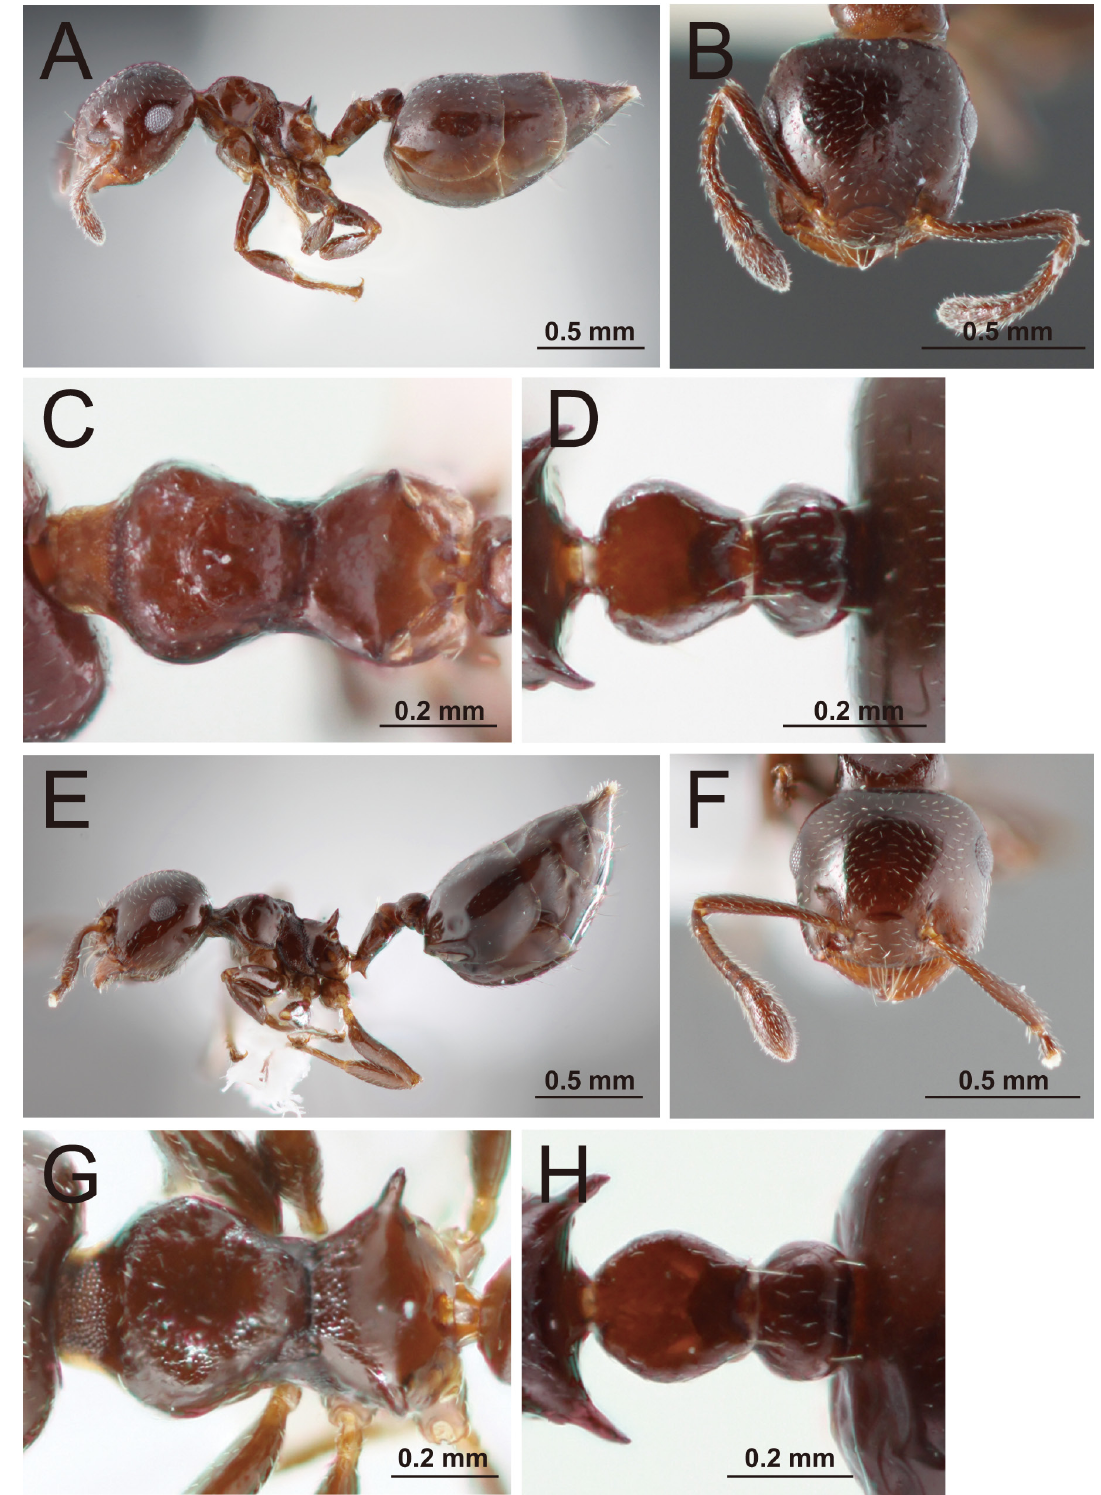
Fig. 4. A–D . Crematogaster khmerensis sp. nov., worker. A . Body in lateral view. B . Full-face view of head. C . Dorsal view of mesosoma. D . Petiole and postpetiole in dorsal view. — E–H . — Crematogaster pfeifferi sp. nov., worker. E . Body in lateral view. F. Full-face view of head. G . Dorsal view of mesosoma. H . Petiole and postpetiole in dorsal